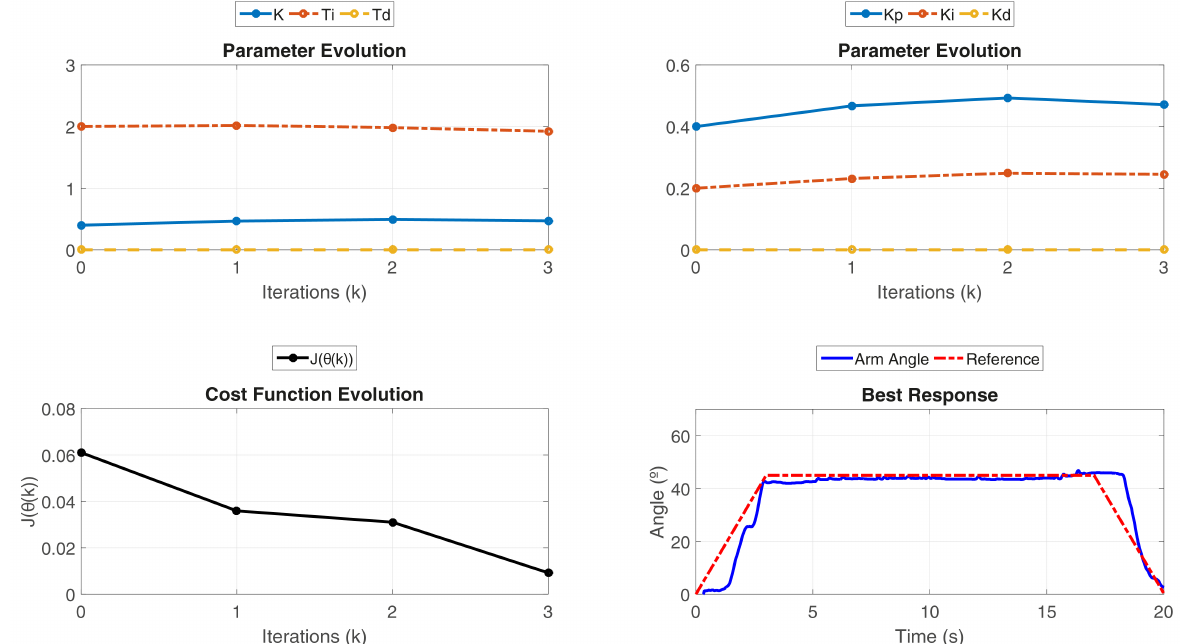
Figure 7 - Adaptive PID (volunteer 2): PID parameters during ES adaptation of the closed-loop system, the evolution of the cost function, and the best response y ultimately obtained after k = 3 iterations. ES reduces the cost function J ( θ ( k )) , which produces a more favorable tracking response. Note that the derivative portion is again barely activated during the experiments.